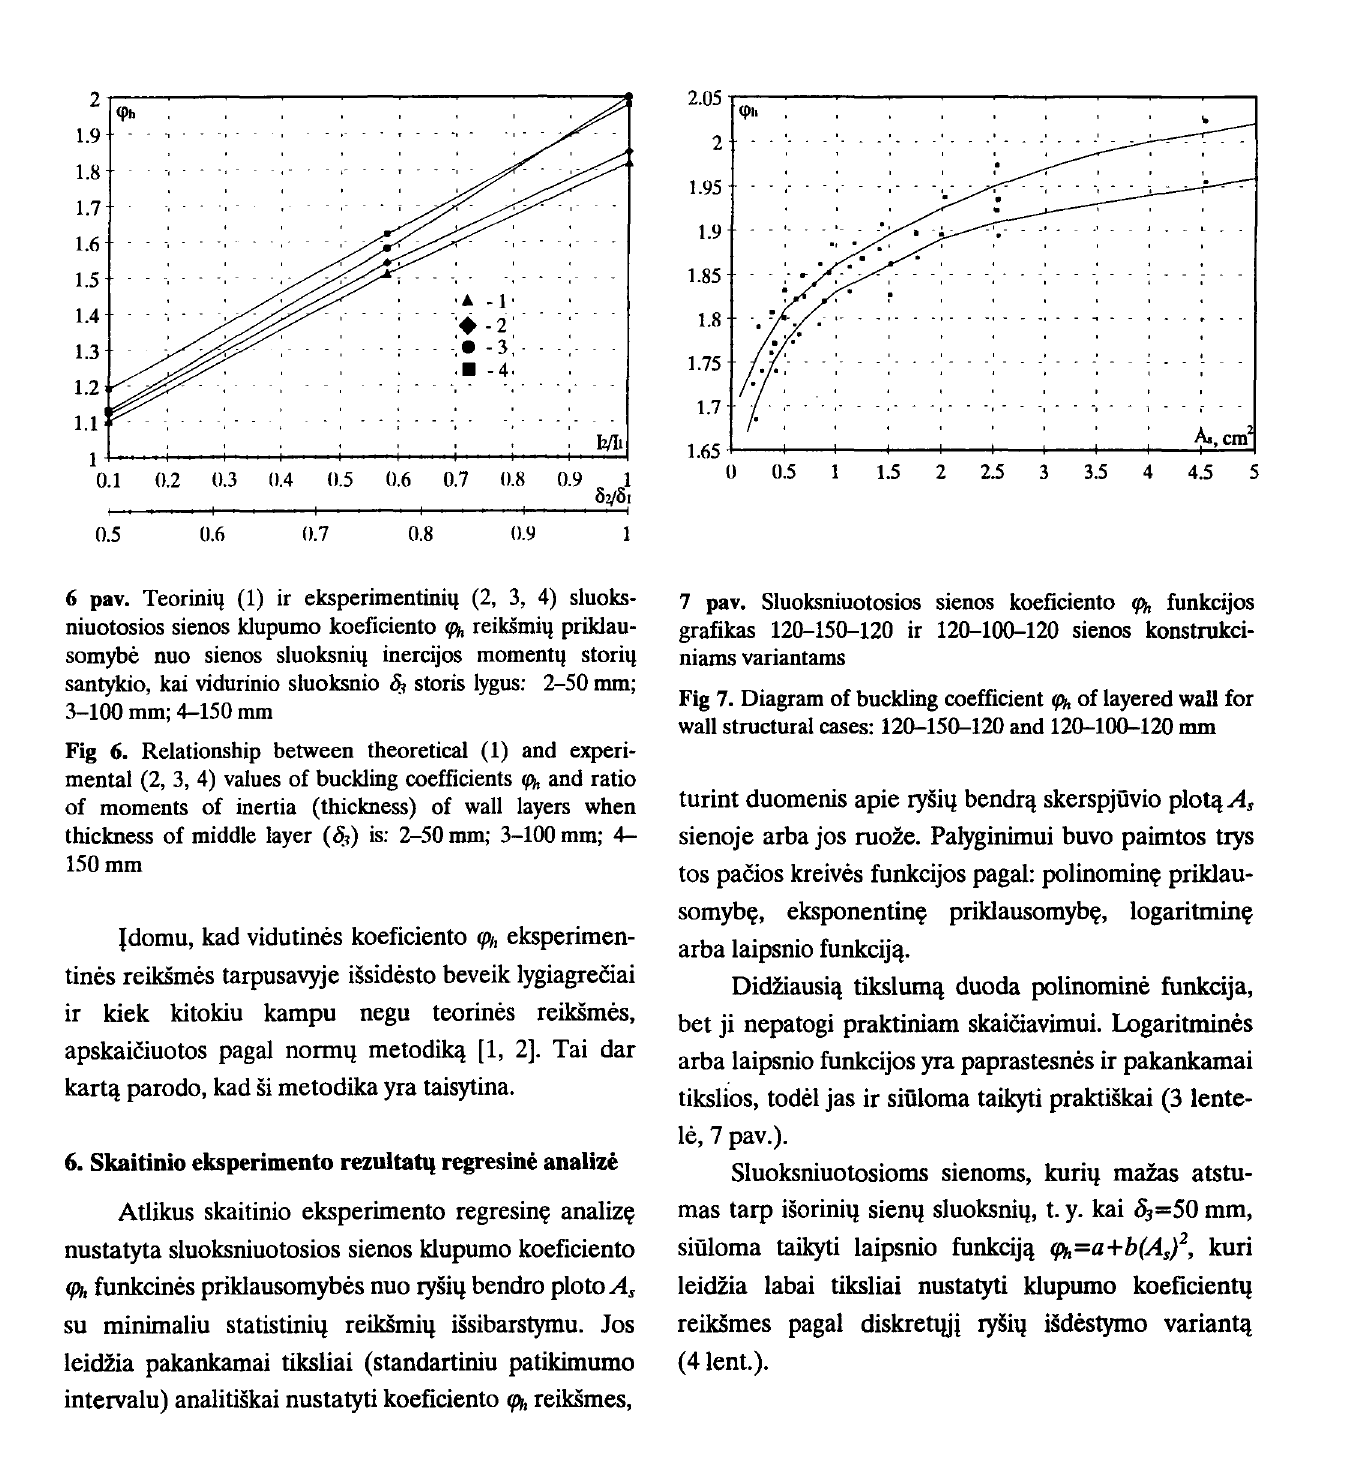
Teorines (mm) koeficiento